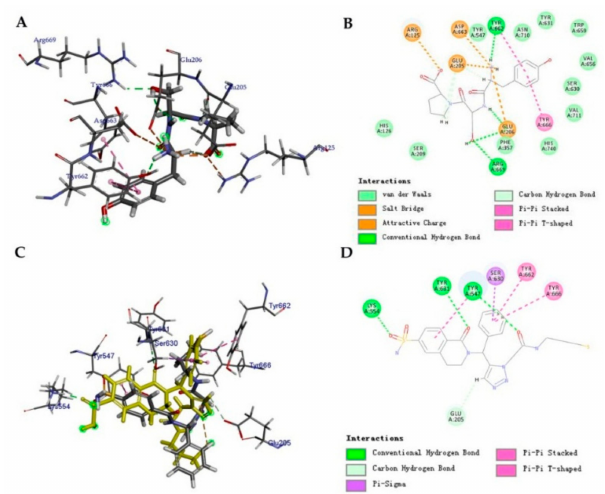
Figure 3. Molecular docking results. ( A ) The docking pose of dpp4_42. ( B ) The non-bonded interactions between dpp4_42 and DPP-IV. ( C ) The docking pose of dpp4_45 and derivative dpp4_45_evo_1 (colored in yellow). ( D ) The non-bonded interactions between dpp4_45_evo_1 and DPP-IV.